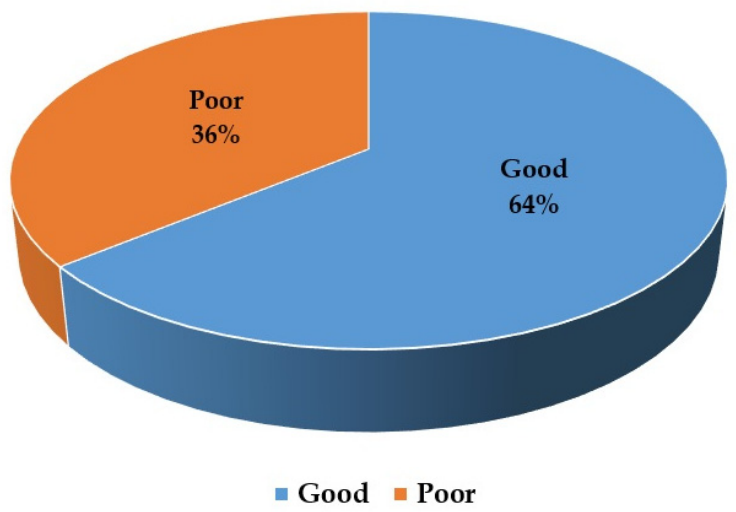
Figure 2. Knowledge level of the participants about COVID-19. Table 2. Knowledge of the participants about COVID-19.